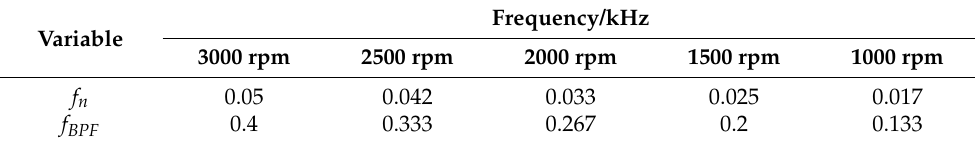
Table 2. Shaft frequency and blades frequency at different impeller speeds.